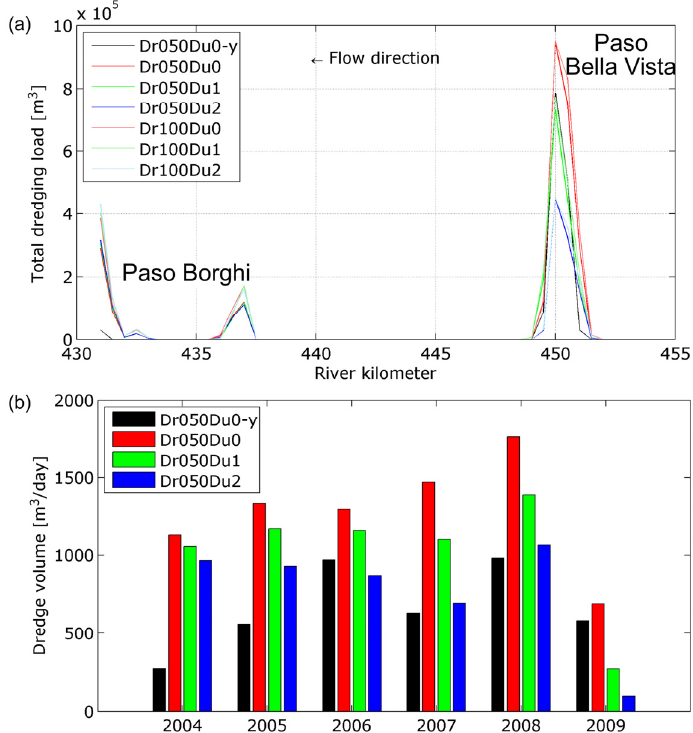
Figure 8. ( a ) Total dredging loads over the six year simulation period and ( b )